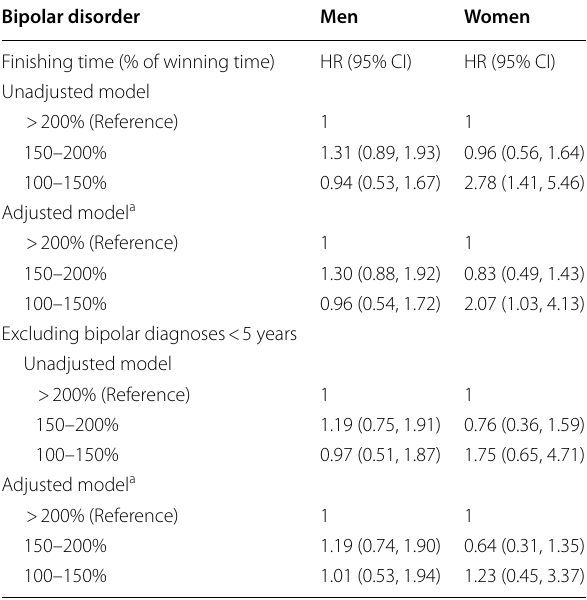
C ox regression models showing HR for risk of bipolar disorders in men and women respectively a Model adjusted for age and